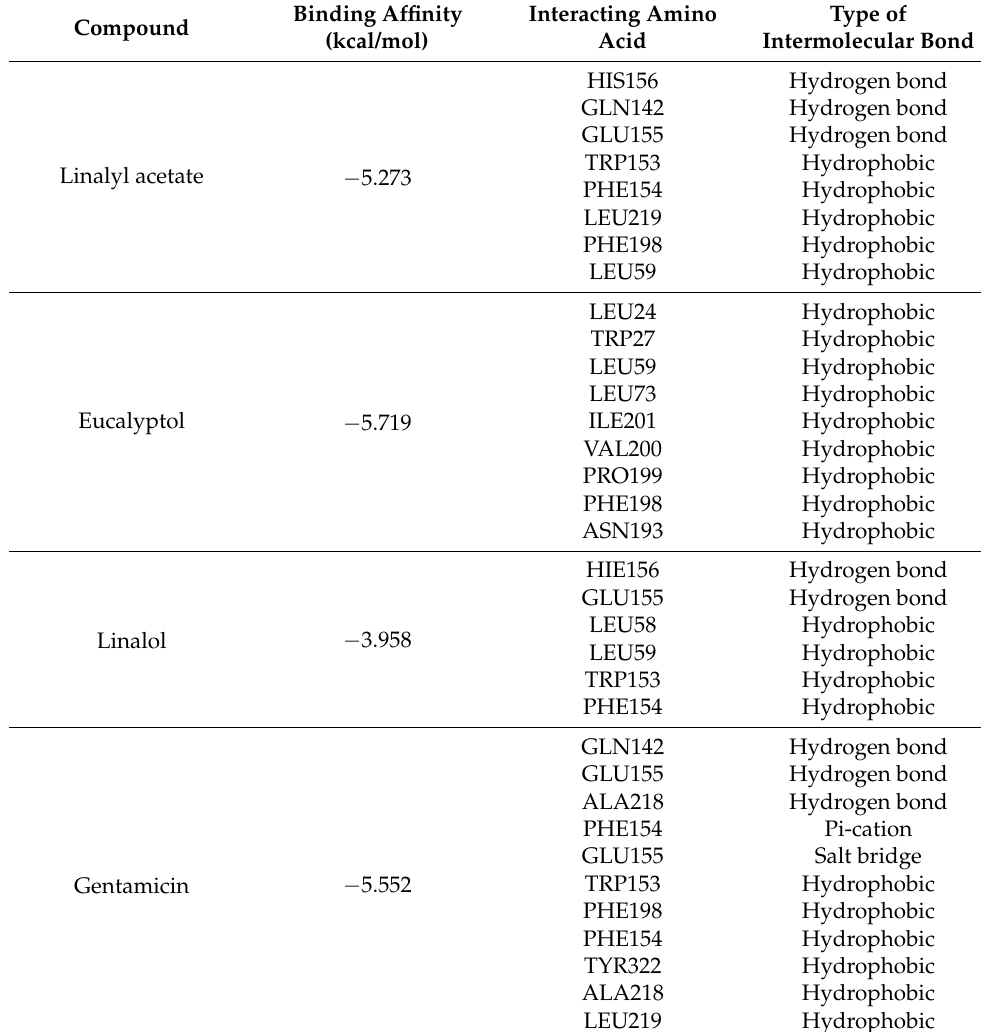
Table 4. The binding affinities and detailed interaction studies of lead compounds from L. officinalis with Escherichia coli 1VLY